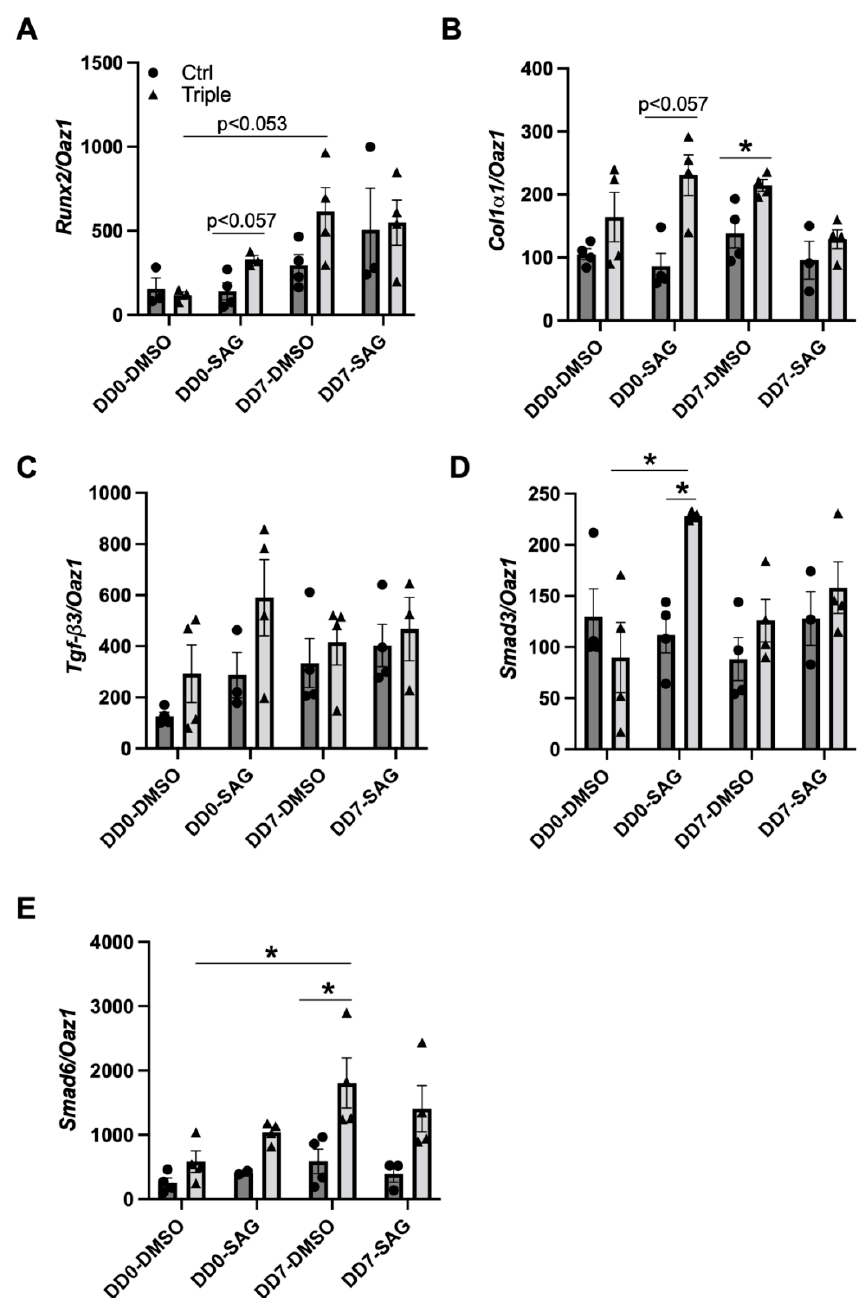
Figure 6. Transcripts of Thm2 − / − ; Thm1 aln/+ calvarial-derived osteoblasts. qPCR for ( A ) Runx2 ; ( B ) Col1 α 1 ; ( C ) Tgf- β 3 ; ( D ) Smad3 ; ( E ) Smad6 , using RNA extracts of P10 control and Thm2 − / − ; Thm1 aln/+ calvarial-derived osteoblasts at differentiation day 0 (DD0) or DD7 treated with either DMSO or SAG. n = 4 control, n = 4 triple allele mutant from 3 litters. Data points represent individual mice. Bars represent mean ± SEM. Statistical significance was determined using Mann-Whitney tests for comparison between control and triple allele mutant samples within a treatment group and using one-way ANOVA followed by Tukey’s test for comparison between treatment groups for control or triple allele mutant samples, respectively. * p < 0.05.